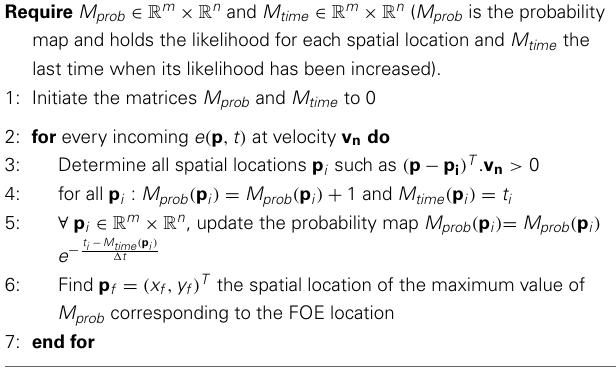
Algorithm 1 | Computation of the Focus Of Expansion.